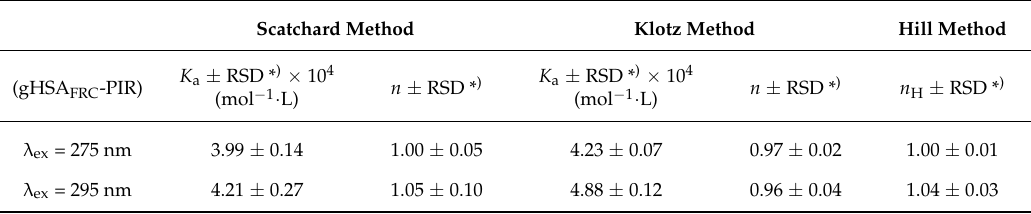
Table 4. Association constants K a (mol − 1 · L), mean number of GLZ molecule bound with one molecule of gHSA FRC -PIR ( n ) , and the Hill’s coefficient ( n H ) in the gHSA FRC -PIR system; λ ex = 275 nm and λ ex = 295